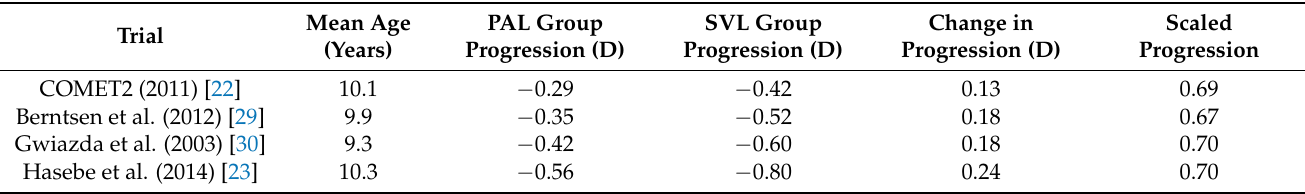
Table 1. Comparison of variability of spherical equivalent refraction (SER) progression outcomes after 12 M follow-up in a subset of four highest quality clinical trials of progressive addition spectacle lenses (PALs) defined as dimensionless scaled progression to the change in progression in